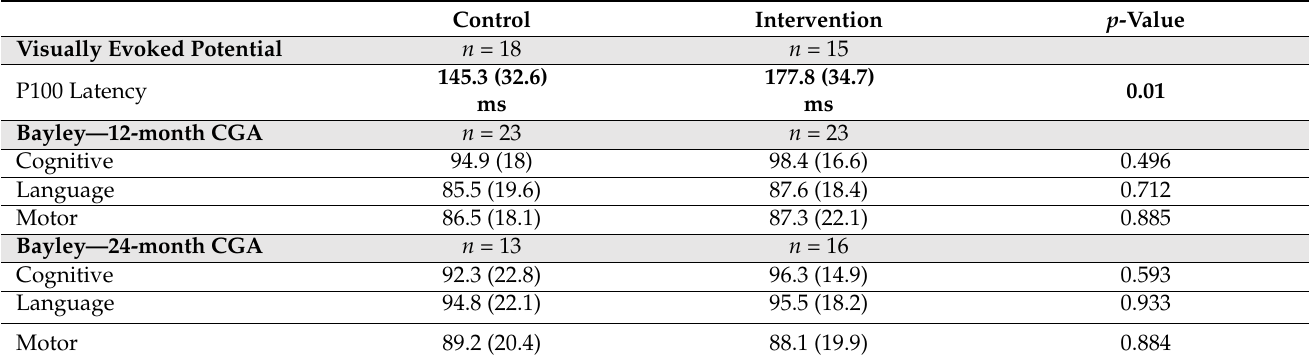
Table 3. Neurodevelopmental outcomes by randomization group—univariate analysis. Results displayed as mean